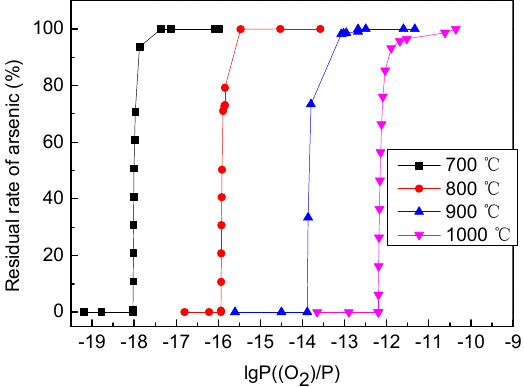
Figure 4. E ff ect of partial pressure of oxygen on residual rate at di ff erent Figure 4. Effect of partial pressure of oxygen on residual rate at different temperatures.